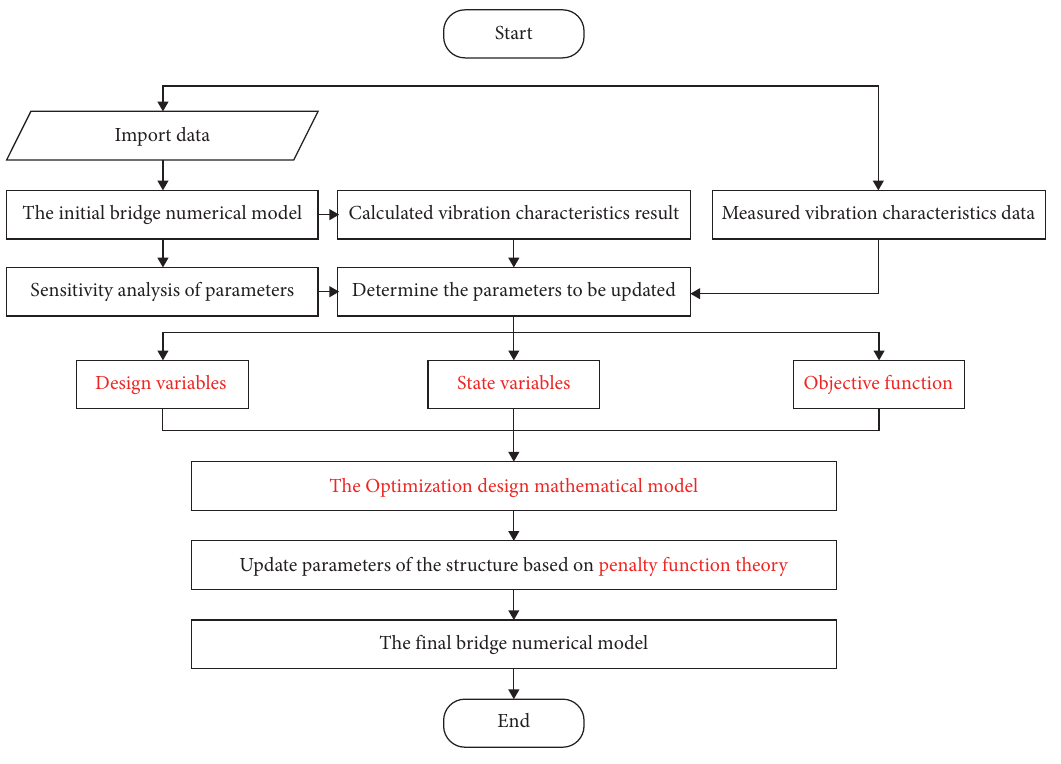
Figure 1: The flow chart of updating the bridge